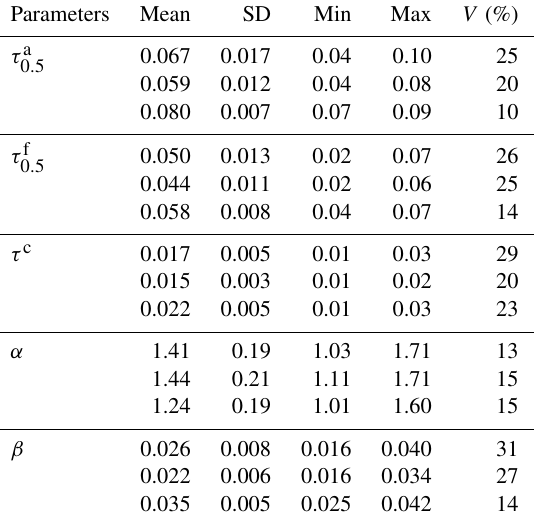
Table 3. Statistical characteristics of the annual AOD: average, min- imal (Min) values, maximal (Max) values, standard deviations (SD) and variation coefficients ( V ). In each horizontal panel of the table, values for Ny-Ålesund (2002–2018) are shown in the first row, val- ues for Ny-Ålesund (2011–2018) are shown in the second row and values for Barentsburg (2011–2018) are shown in the third